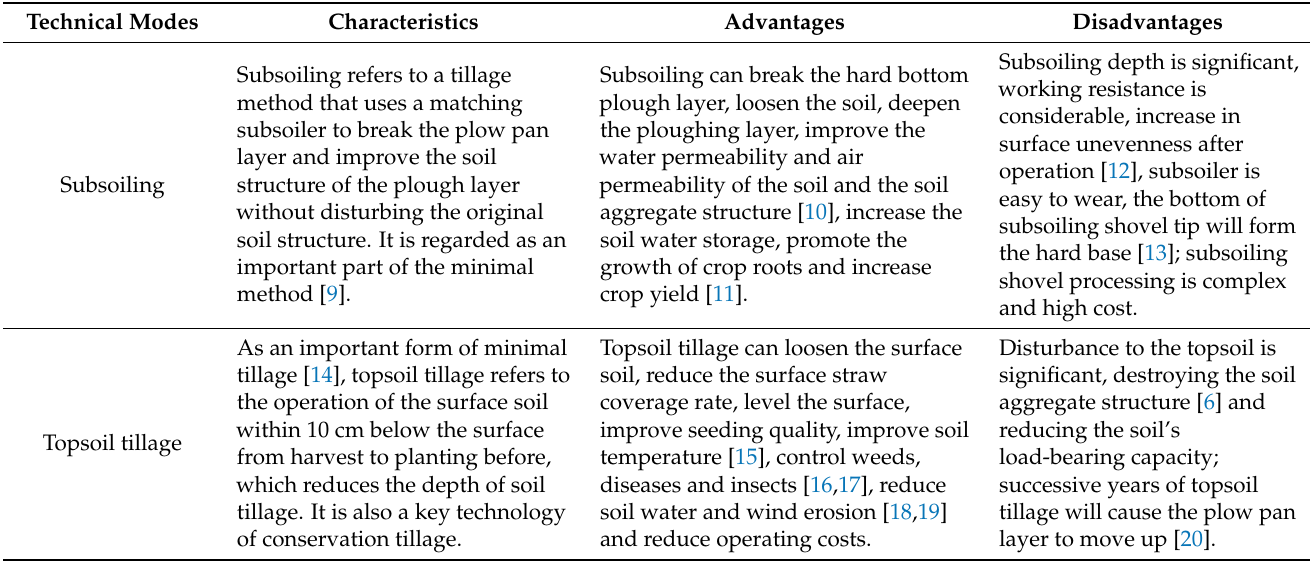
Table 1. Typical technology model of minimal